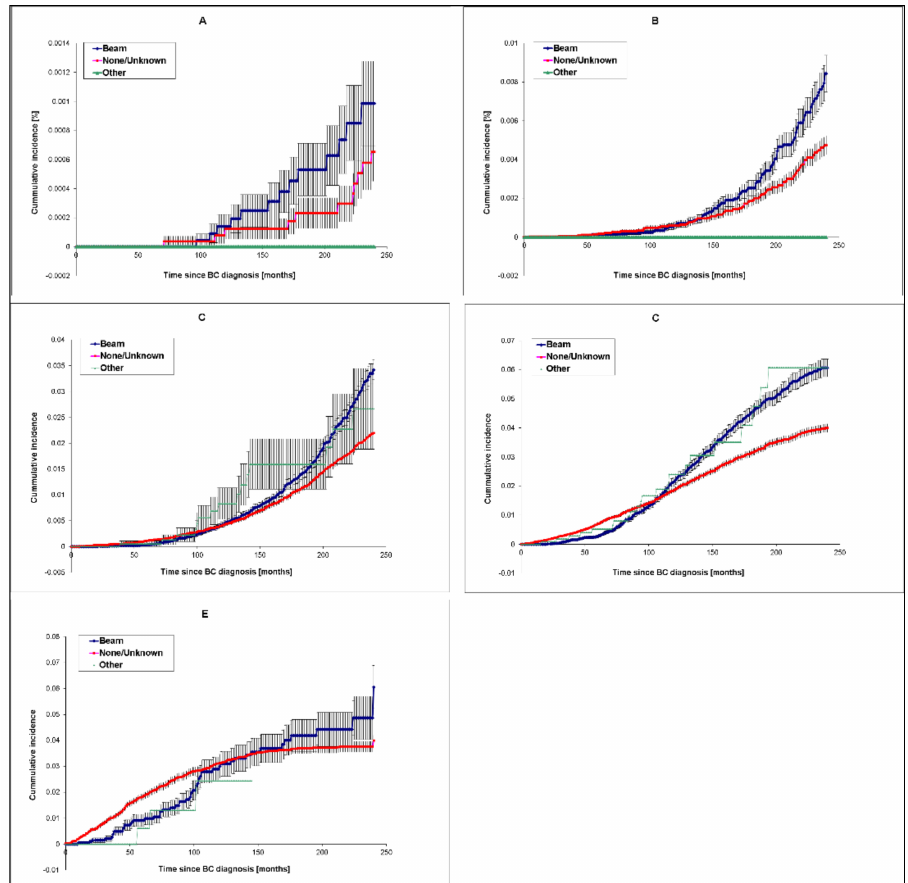
Figure 4. E ff ect of radiotherapy on cumulative incidence of AD death for white women diagnosed with BC. Data for the age groups of 45–54 years ( A ), 55–64 years ( B ), (65–74 years ( C ), 75–84 years ( D ), and 85 + years ( E ) are shown. For simplicity, only data for the beam radiotherapy are presented. Error bars indicate standard errors